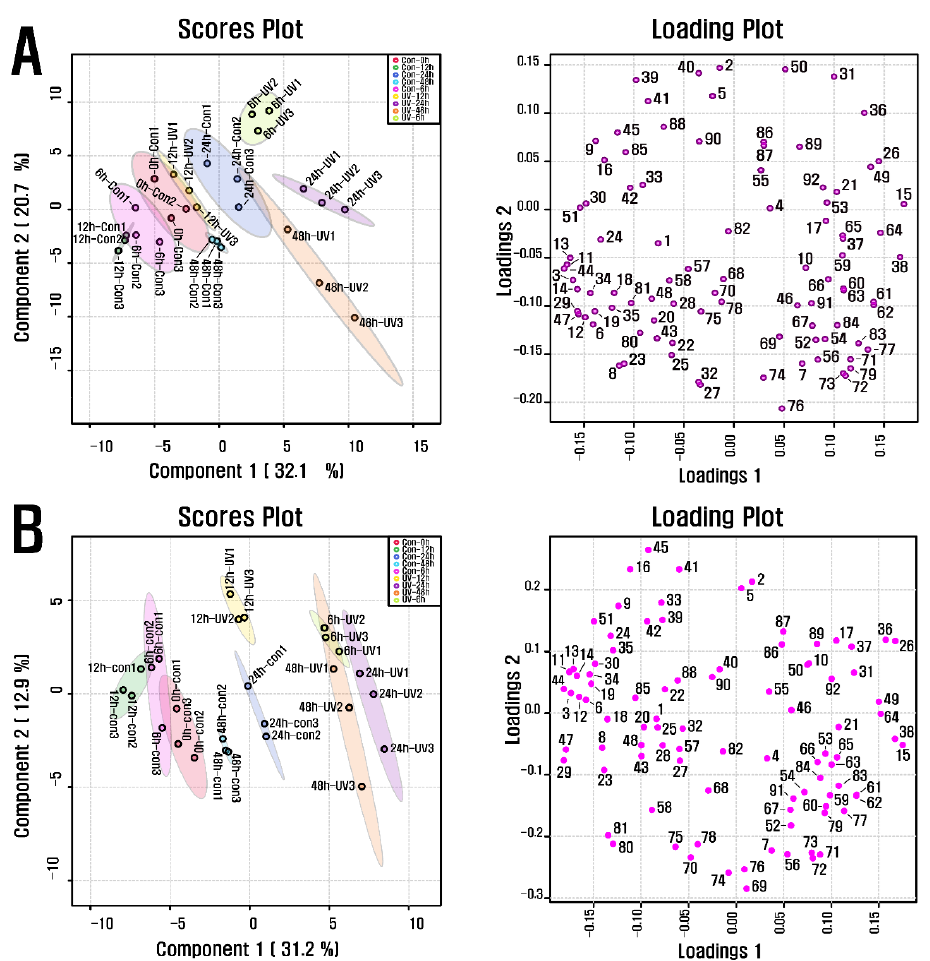
Figure 2. ( A ) Scores and loading plots of PCA model for metabolites present in UVB-irradiated purple kohlrabi sprouts and ( B ) Scores and loading plots of PLS-DA model for metabolites present in UVB-irradiated purple kohlrabi sprouts. Control, purple kohlrabi sprouts grown without UVB treatment for 0 h, 6 h, 12 h, 24 h, and 48 h; test, purple kohlrabi sprouts irradiated with UVB radiation for 6 h, 12 h, 24 h, and 48 h. Number: 1, Pyruvic acid; 2, Lactic acid; 3, Alanine; 4, Oxalic acid; 5, Glycolic acid; 6, Valine; 7, Urea; 8, Ethanolamine; 9, Phosphoric acid; 10, Glycerol; 11, Leucine; 12, Isoleucine; 13, Proline; 14, Glycine; 15, Succinic acid; 16, Glyceric acid; 17, Fumaric acid; 18, Serine; 19, Threonine; 20, β -Alanine; 21, Malic acid; 22, Aspartic acid; 23, Methionine; 24, Pyroglutamic acid; 25, 4-Aminobutyric acid; 26, Threonic acid; 27, Cysteine; 28, Glutamic acid; 29, Phenylalanine; 30, Xylose; 31, Arabinose; 32, Asparagine; 33, Xylitol; 34, Putrescine; 35, Glutamine; 36, Shikimic acid; 37, Citric acid; 38, Quinic acid; 39, Fructose; 40, Mannose; 41, Glucose; 42, Man- nitol; 43, Lysine; 44, Tyrosine; 45, Inositol; 46, Ferulic acid; 47, Tryptophan; 48, Sinapinic acid; 49, Fructose-6-phosphate; 50, Glucose-6-phosphate; 51, Sucrose; 55, Cyanidin 3-(caffeoyl)diglucoside-5- glucoside; 57, Cyanidin 3-(feruloyl)diglucoside-5-glucoside; 58, Cyanidin 3-diglucoside-5-xyloside;